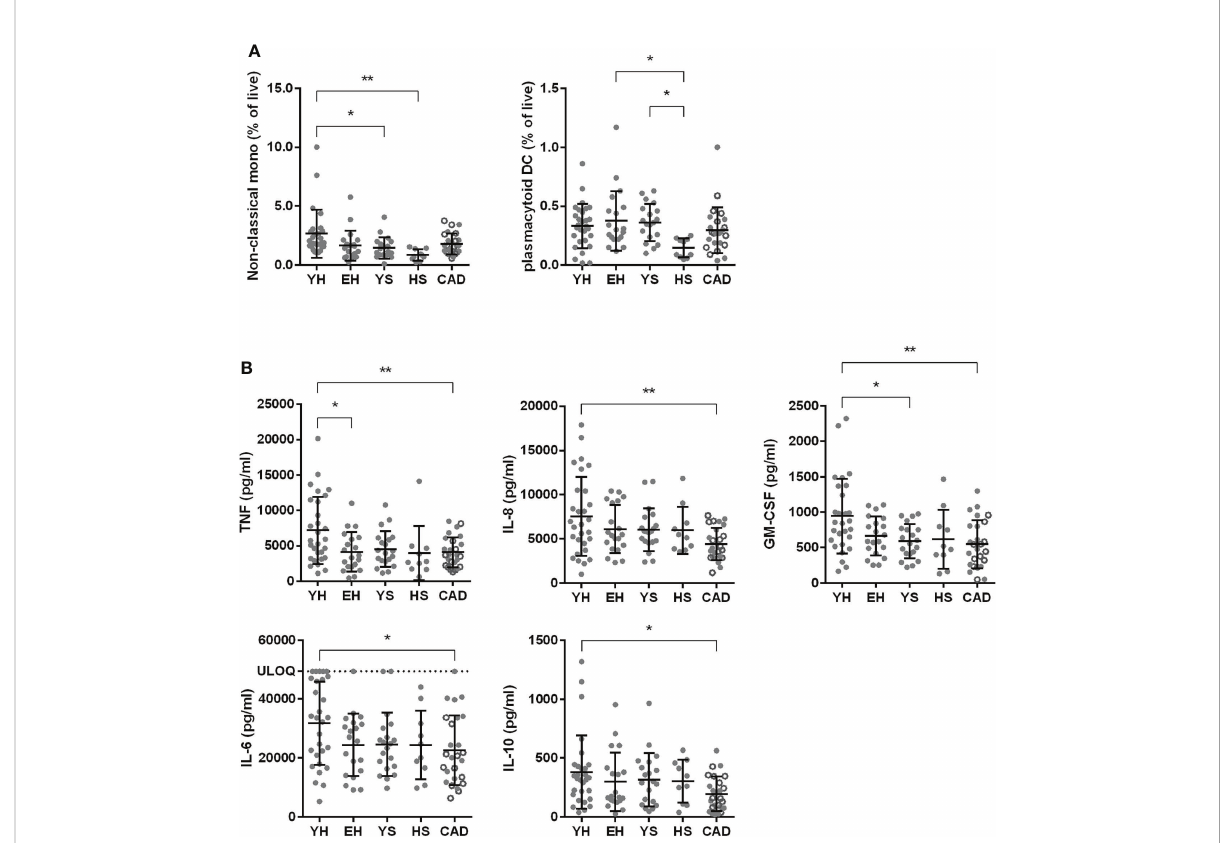
FIGURE 3 Effect of ageing and smoking on myeloid cells. Percentage of non-classical monocytes (CD14 - CD16 + ) and plasmacytoid dendritic cells (HLA- DR + , CD19 - , CD14 - , CD123 + ) in whole blood as assessed by fl ow cytometry (A) . Whole blood was stimulated with 2 ng/ml LPS and cytokine release was measured using LegendPlex (B) . YH, young healthy; EH, elderly healthy; YS, young smoker; HS, heavy smoker; CAD, coronary artery disease patient. Open circles in the CAD group represent smokers. Statistics was performed using one-way ANOVA with Dunnett ’ s post hoc test, means were compared to the YH group. P values ≤ 0.05 are considered signi fi cant. * p ≤ 0.05, ** p ≤